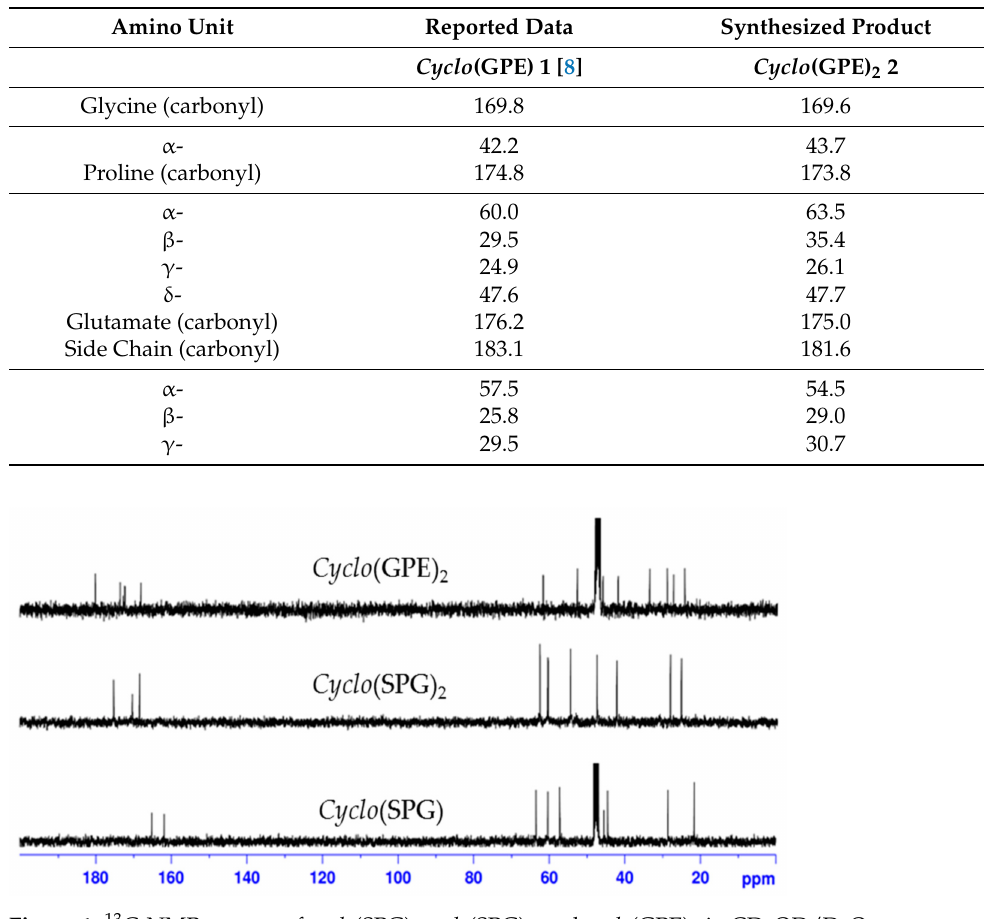
Figure 1. 13 C-NMR spectra of cyclo (SPG), cyclo (SPG) 2 and cyclo (GPE) 2 in CD 3 OD/D 2